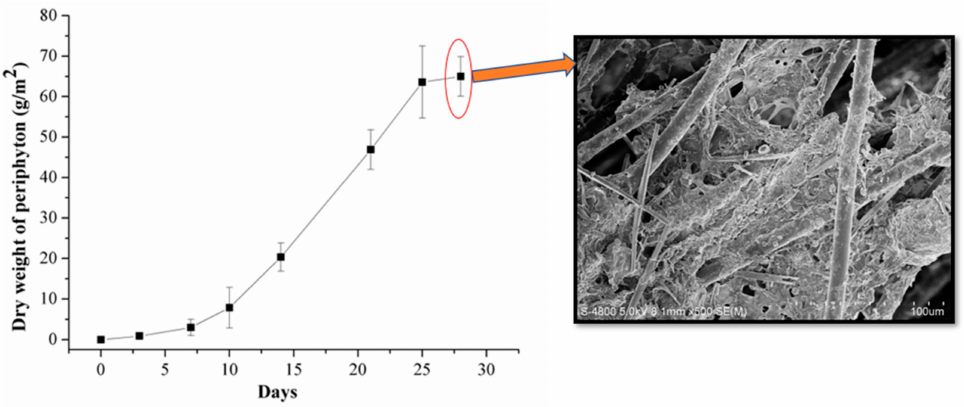
Figure 1. The dry weight of periphyton during the culture and the SEM image of periphyton at day 28.